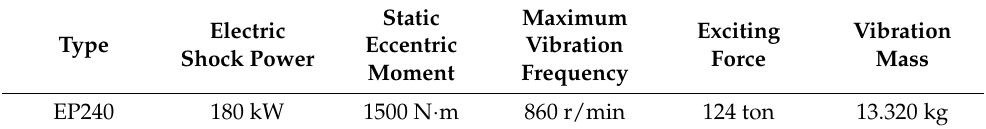
Table 2. Parameter of apparatus.